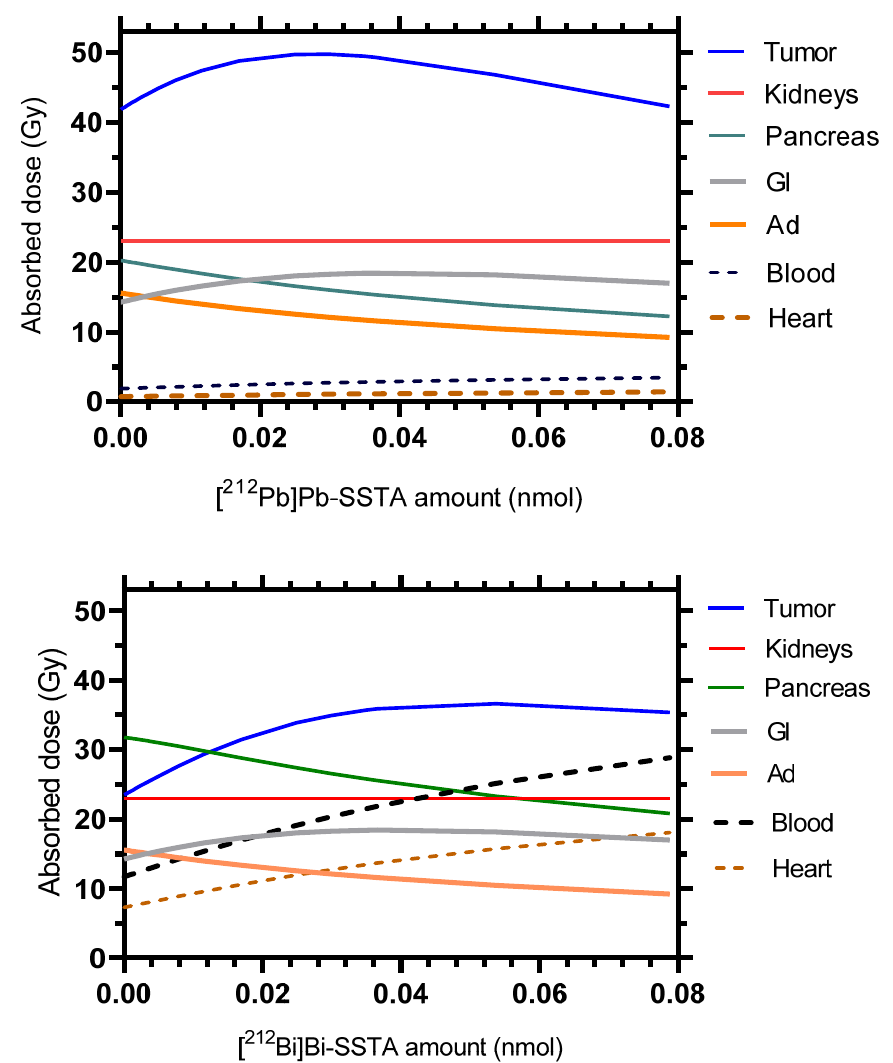
Figure 5. Therapeutic potencies of the in vivo alpha generator [ 212 Pb]Pb-SSTA (upper panel) and [ 212 Bi]Bi-SSTA (lower panel). The absorbed doses in different mouse tissues were calculated for different injected amounts, with activity chosen such that kidneys always received a dose of 23 Gy. The absorbed doses in the other tissues of the model are presented in Supplementary Material Figure S1. Table 2. Total absorbed dose coefficients (ADC) and the contributions of the in vivo alpha particle generator [ 212 Pb]Pb- DOTAMTATE and its radioactive decay products to the total absorbed doses in SSTR2-expressing and non-SSTR2- expressing tissues.